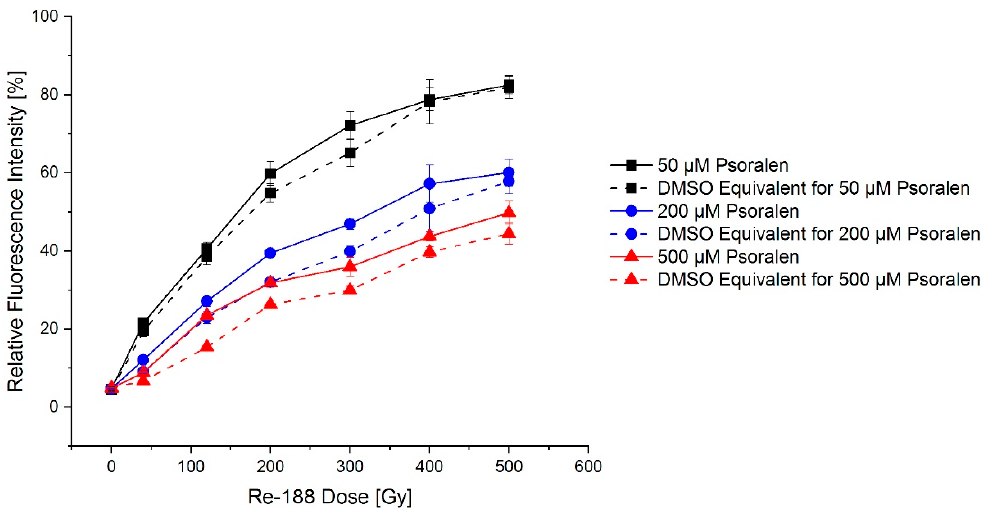
Figure 8. Exemplary dose–effect relation for Re-188 in combination with psoralen after 24 h incubation demonstrated an increasing fraction of open circular plasmid DNA. The influence of DMSO was tested. Psoralen produced a small additional effect, as visible in the difference between the continuous and dashed line. The error bars show the SEM.